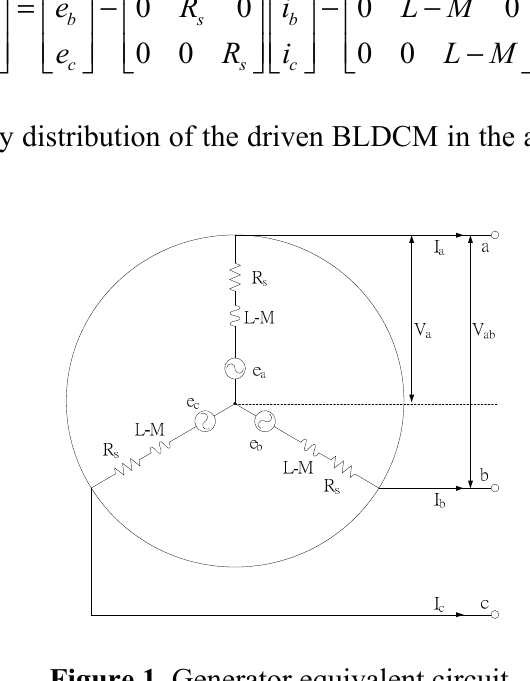
Figure 1. Generator equivalent circuit.